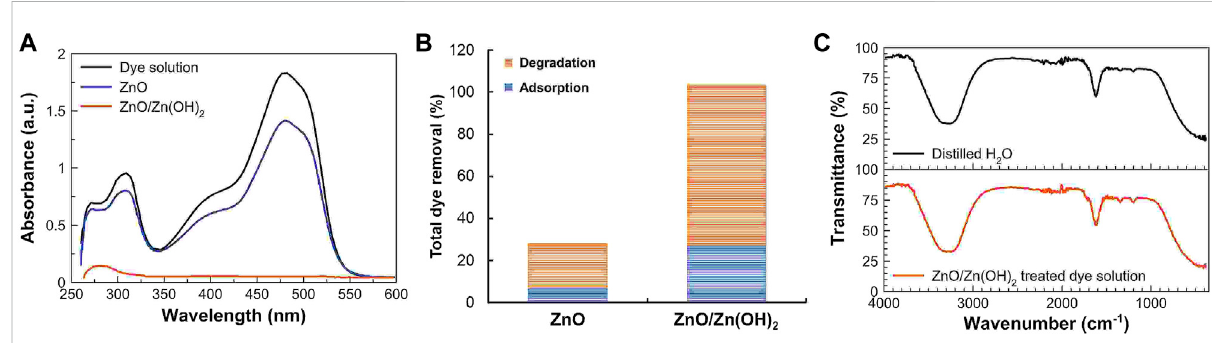
FIGURE 2 (A) UV-visspectraoftheaqueoussolutionofsunsetyellowanditsexposuretoUVlightinthepresenceofZnOandZnO/Zn(OH) 2 nanoparticles. (B) The overall dye removal shows the photocatalytic degradation performance of ZnO and ZnO/Zn(OH) 2 nanoparticles. (C) FTIR spectra of the distilled H 2 O and ZnO/Zn(OH) 2 nanoparticles treated dye